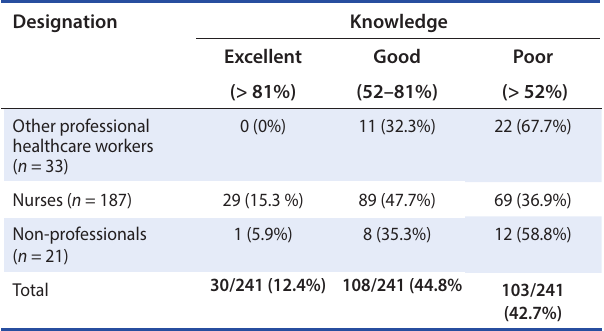
Table 3: Overall knowledge of healthcare workers about healthcare waste Designation